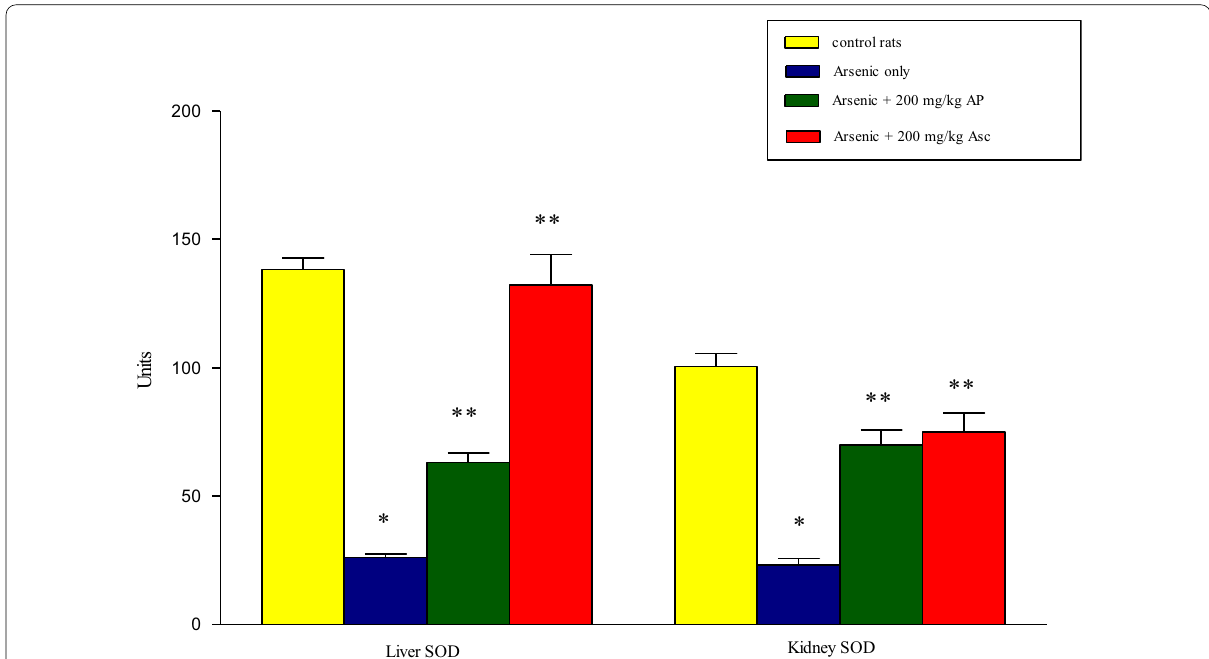
Fig. 3 Effect of methanolic extract of A. paniculata on hepatic and renal SOD activities in arsenic-induced rats. Values are mean *( p < 0.05) Group 2: (arsenic group rats) compared with group 1: (control rats). **( p < 0.05) Groups 3 and 4: ( A. paniculata or ascorbic acid administered rats, respectively) compared with group 2: (arsenic group rats)